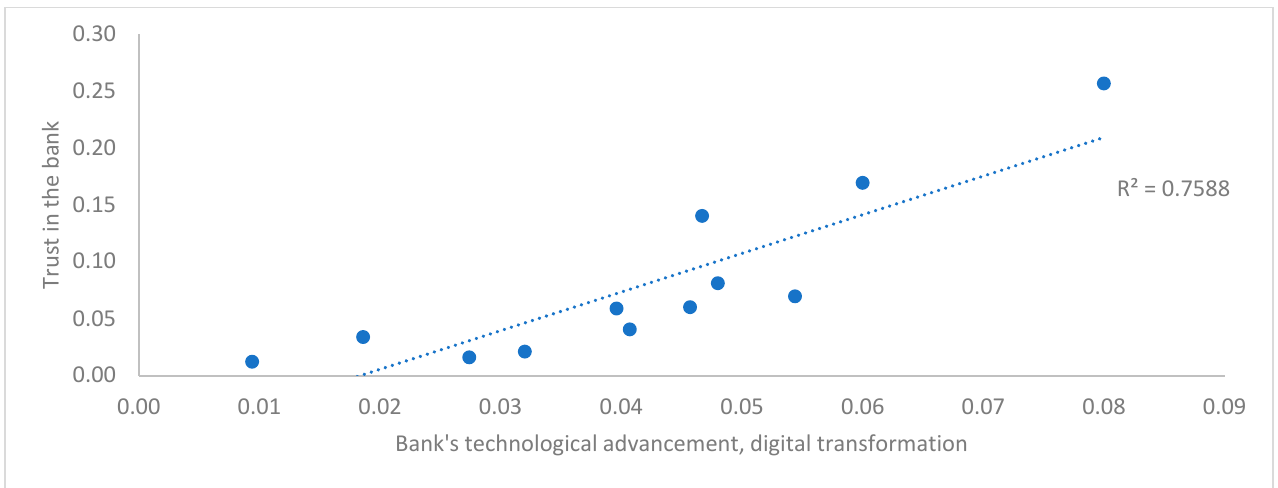
Figure 5. Customer trust in their bank in relation to bank technological advances, 2Q 2021. Source: own computation based on data from ZBP 2021.